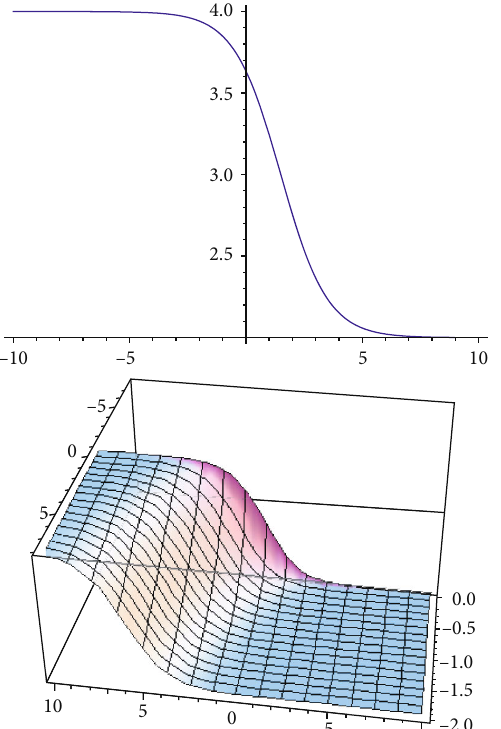
Figure 3: 2D and 3D graphics for hyperbolic traveling wave solution (28) at f β = 0 : 5, r = 1, q = 1, c = 1 g